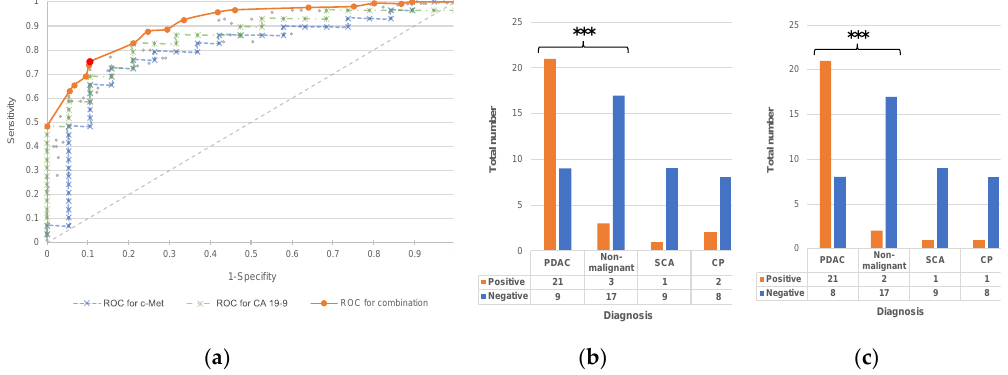
Figure 2. ( a ) Receiver operating characteristics curve of a diagnostic test based on c-Met, carbohydrate antigen 19-9 (CA 19-9) and the combination of both. ( b ) Contingency table of a test based on c-Met, using a cutoff value of >495. ( c ) Contingency table of a test based on the combination of c-Met and CA 19-9, using c-Met >543 or CA 19-9 >97 U/mL as cutoff. *** significant at 0.1% level ( p < 0.001). Table 5. Comparison of sensitivity, specificity and odds ratio of diagnostic test based on c-Met and CA 19-9 alone or in combination.